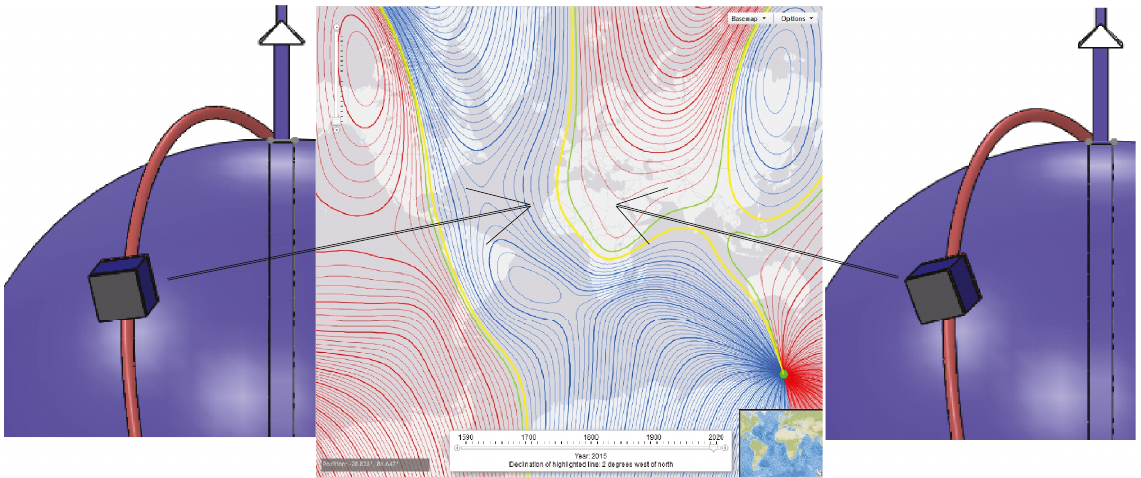
Figure 16: A map of magnetic fi eld declination produced from historical data available at the National Centers for Environmental Information under NOAA. The yellow isogonic line indicates a shift in magnetic declination. Blue lines indicate western declination, and red lines indicate eastern declination. Whenever DTUsat-2 is west of the yellow line over Europe, we have observed lesser performance. The left CAD rendering shows the attitude e ff ect of western declination. When DTUsat-2 is east of the yellow line, we see better performance. The right CAD rendering shows the attitude e ff ect of eastern declination. Likewise, Michael Williams, Indiana, USA, has reported lesser performance during DTUsat-2 passes east of the yellow line over the